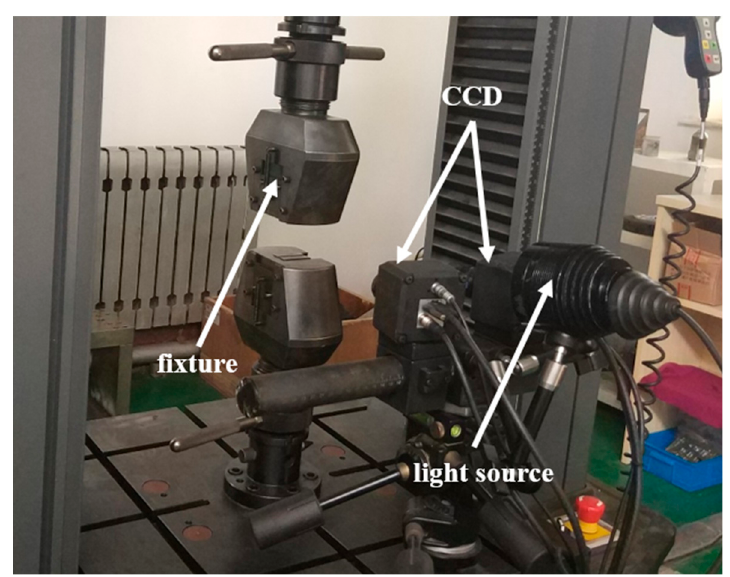
Figure 2. Device schematic of the digital image correlation (DIC) technique.